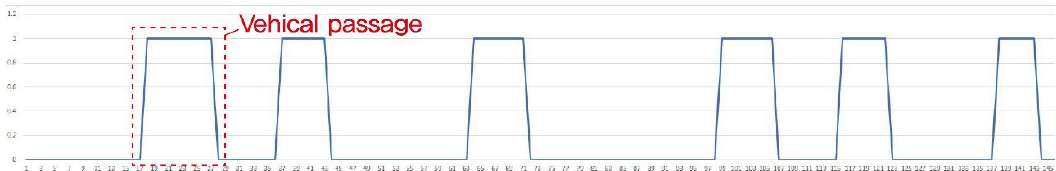
Figure 6. Updated signal profile from the autoencoder when using synthesized images for the test data.